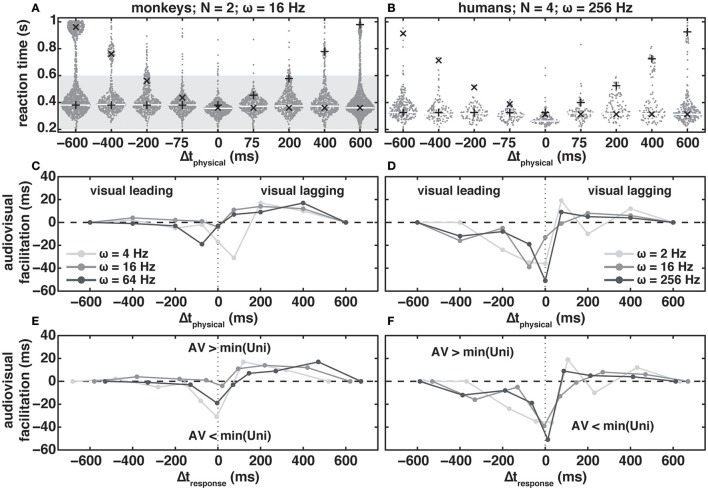
Bee-swarm plots (A,B) for audio-visual reaction times (RTs) in the redundant target paradigm as a function of modulation frequency, ω, for two monkeys (A) and four humans (B). Modulation depth, ΔM, and luminance difference, ΔLv, were 25% and 1.26 cd/m2, respectively. Dots indicate individual RTs and the white (monkeys) and light gray (humans) horizontal lines the mode of the audio-visual distribution. Black “pluses” and “crosses” indicate the mode of visually and auditory evoked RTs in the Δt = −600 ms and Δt = 600 ms conditions, respectively, shifted by Δtphysical. Note that in contrast to the monkeys, humans were not rewarded and did not receive feedback for responding within the reward window (dark gray patch in (A). Audio-visual facilitation as a function of physical (C,D) and response (E,F) delay for monkeys (C,E) and human subjects (D,F) at three different amplitude-modulation frequencies (shades of gray). Negative and positive values, respectively, indicate a speed-up/decrease and a slow-down/increase of reaction times re. fasted unimodal response. For details see main text.